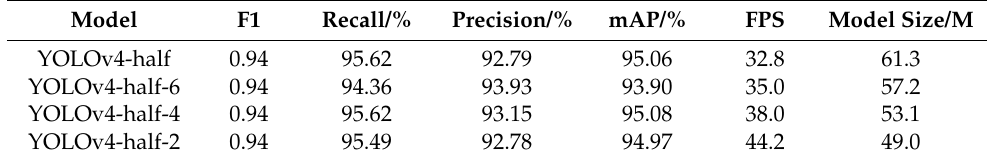
Table 2. Comparison table of depth adjustment